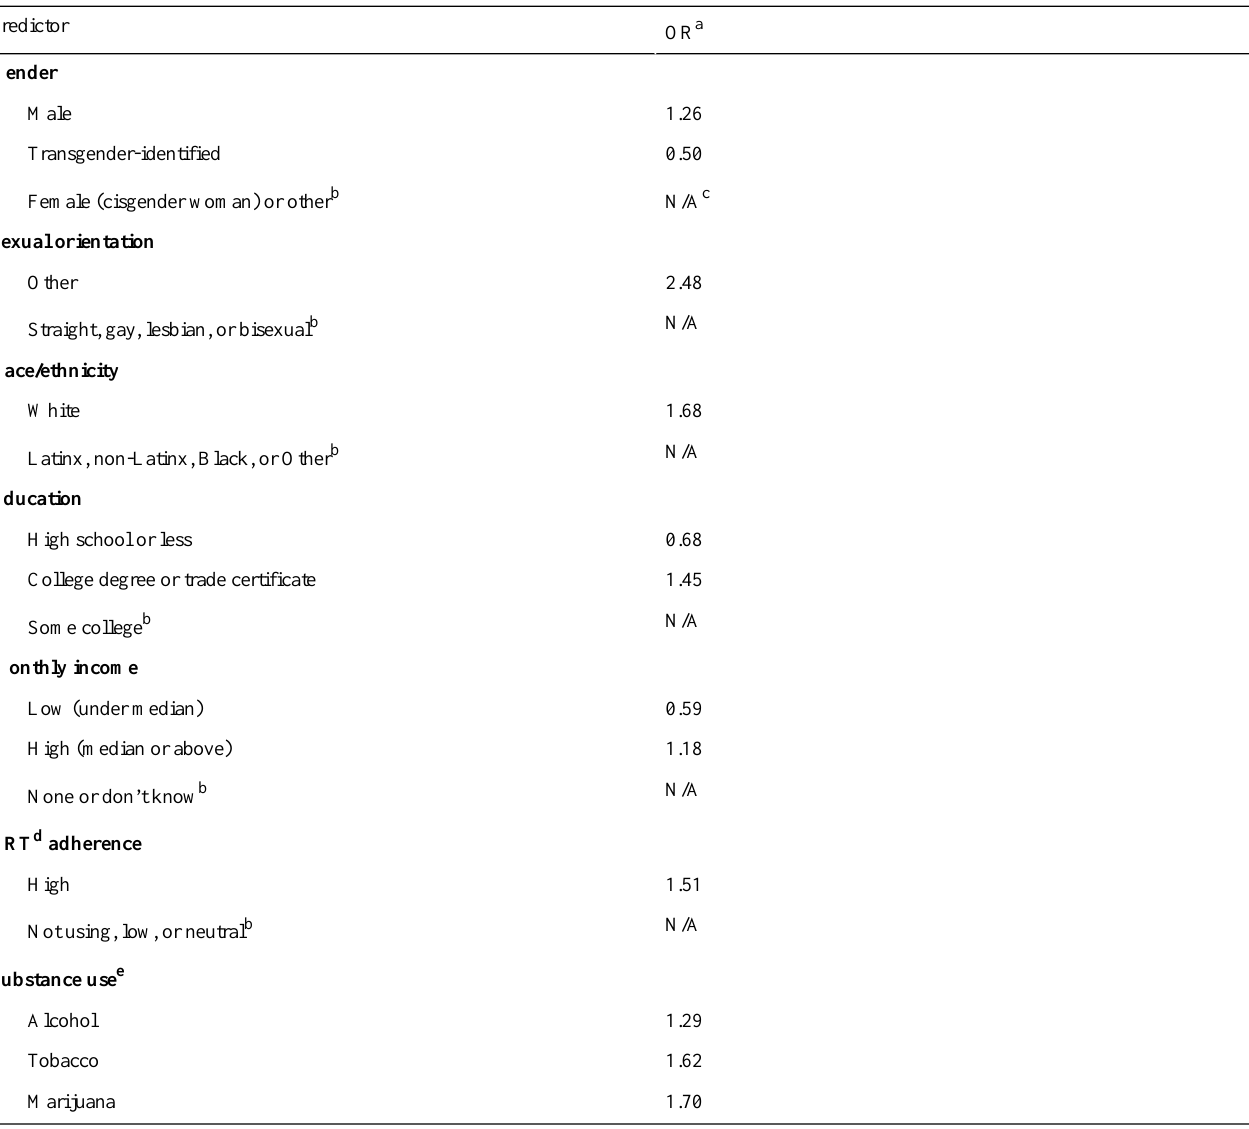
Table 4. Odds ratios from logistic regressions of sexual and reproductive health information seeking through the internet over the past 6 months. Predictors were selected by lasso regression